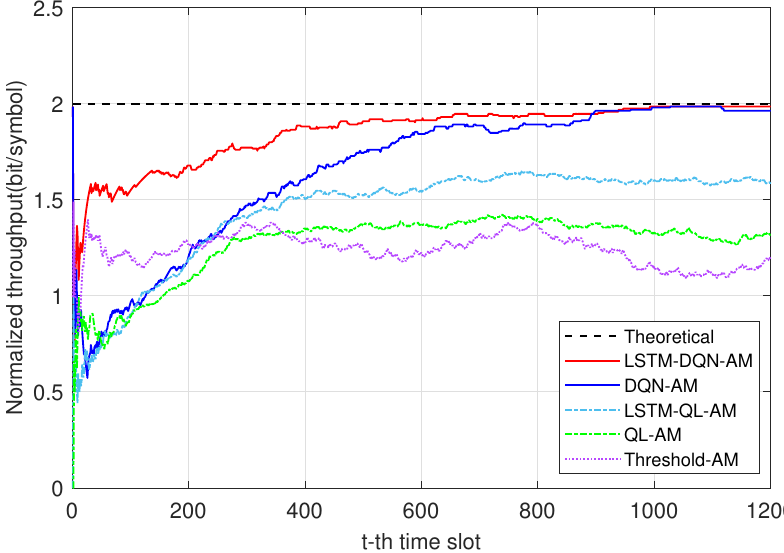
Figure 10. The throughput of the AM methods in the pool